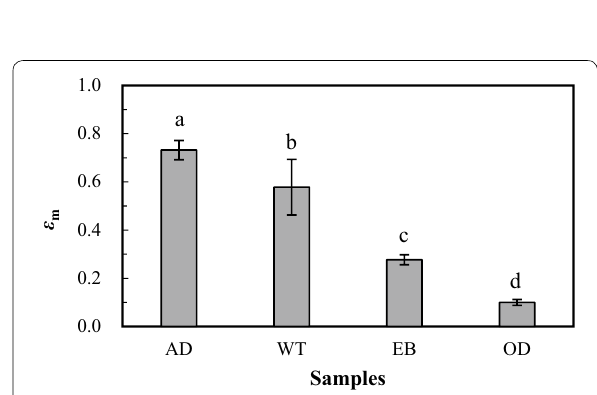
Fig. 8 Maximum strain at the maximum load ( ɛ m ). Means with the same letter (a, b, c, d) are not significantly different (Tukey–Kramer test, p < 0.01) ( n 5). Error bars represent standard deviations =